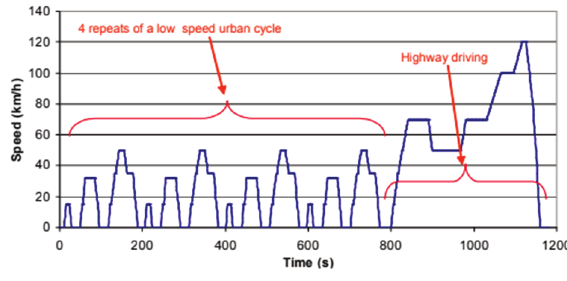
Fig. 7. The NEDC test drive cycle speed profile [1]